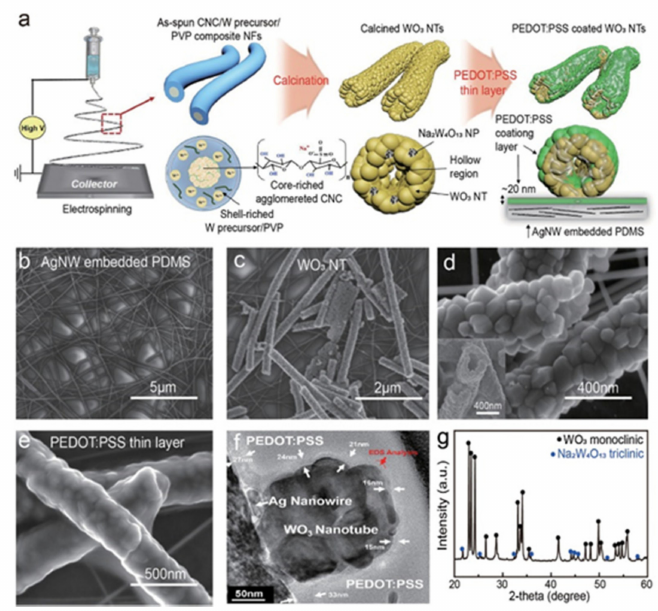
Figure 7. ( a ) Schematic illustration of the fabrication process of WO 3 nanotubes and PEDOT:PSS layer. Characterization of Ag-nanowire-embedded PDMS substrate and WO 3 nanotube–PEDOT:PSS thin layer. Scanning electron microscope images of ( b ) Ag-nanowire-embedded PDMS, ( c ) WO 3 nanotube coated on Ag-nanowire-embedded PDMS, ( d ) cross-section image of a WO 3 nanotube, and ( e ) PEDOT:PSS thin layer coated on a WO 3 nanotube. ( f ) Transmission electron microscope cross-section image of a PEDOT:PSS thin layer coated on a WO 3 nanotube. ( g ) X-ray diffraction results of the WO 3 nanotube